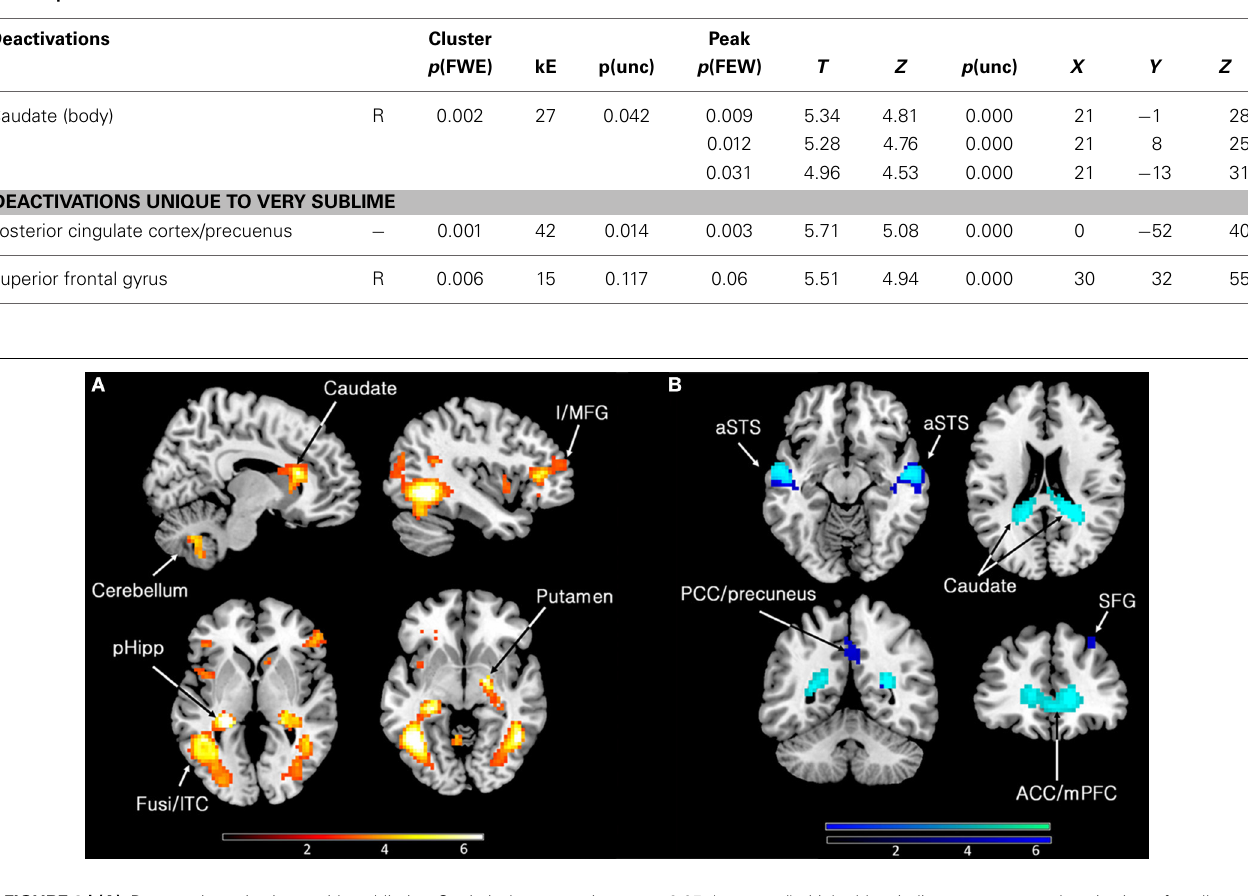
p < 0 . 05 (corrected). Light blue indicates common deactivations for all contrasts, very sublime < baseline, mid sublime < baseline, and not sublime < baseline, and dark blue indicates sites deactivated uniquely during the presentation of the stimuli experienced as “very sublime.” aSTS, anterior superior temporal sulcus (54 − 10 − 8/ − 51 − 16 − 8); SFG, superior frontal gyrus (30 32 55); ACC/mPFC, anterior